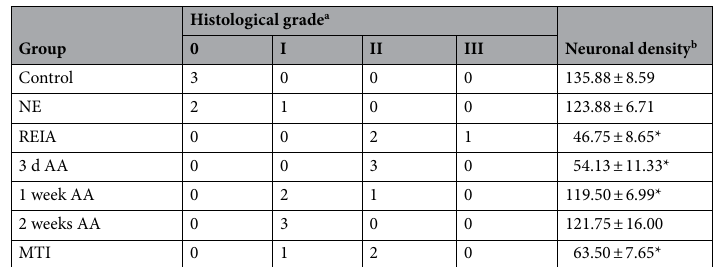
grades and mean ND values of rat brain neurons in each group are shown in Table 1. The mean ND values in the REIA group, 3-d AA group and MTI group were significantly lower than those in the control group ( p = 0.000). The mean ND values in the 1 week AA group were still lower than those in the control group ( p = 0.037), but there was no significant difference between the control group and the NE group or 2 weeks AA group ( p = 0.399 for NE group, p = 0.132 for NE group). Representative Nissl staining of brain sections in the hippocampus of rats in each group is shown in Fig. 4. The cortical neurons in the control group, NE group, 1 week AA group and